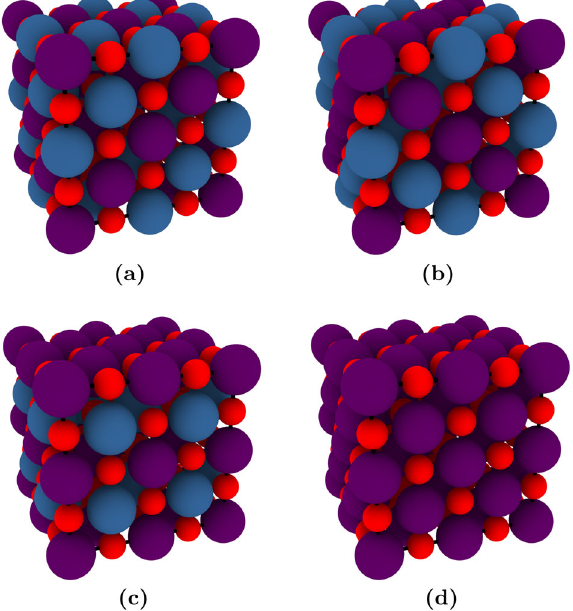
¼ 4 : 461 Å compared to a HSE06